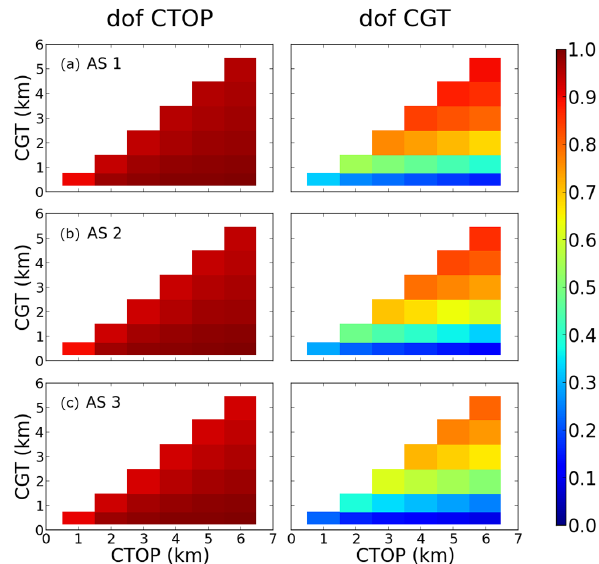
Figure 16. Information content of 3MI A-band for ice clouds (IHM model) for different COTs: (a) COT = 1, (b) COT = 4, (c) COT = 16. Partial DOFs for CTOP (left) and CGT (right).